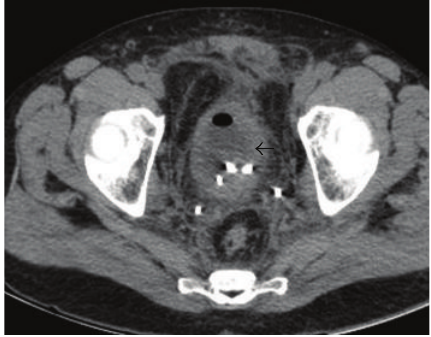
Figure 1: A thickened bladder wall (arrowhead) with stranding of the mesenteric fat, status post-JJ stents. Despite the collapsed bladder, the wall thickening is clearly